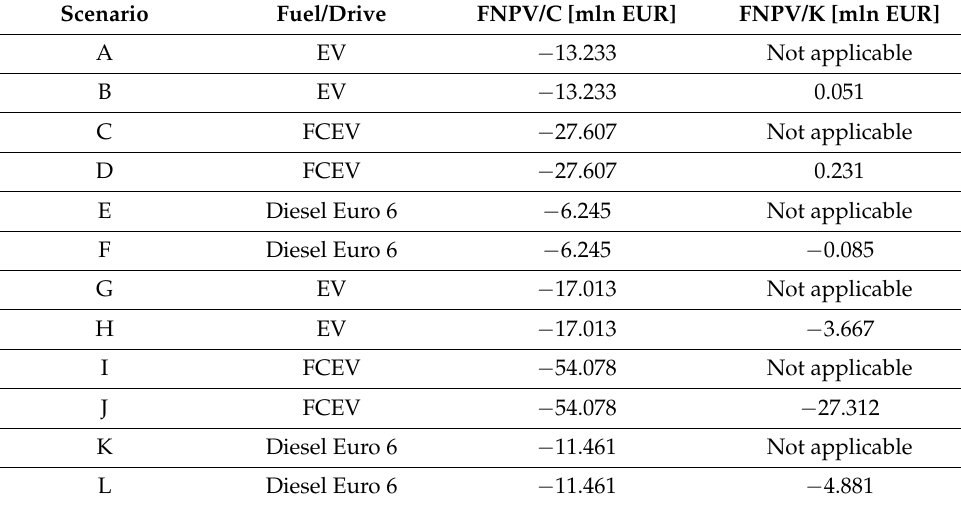
Table 5. Results of effectiveness analysis for particular